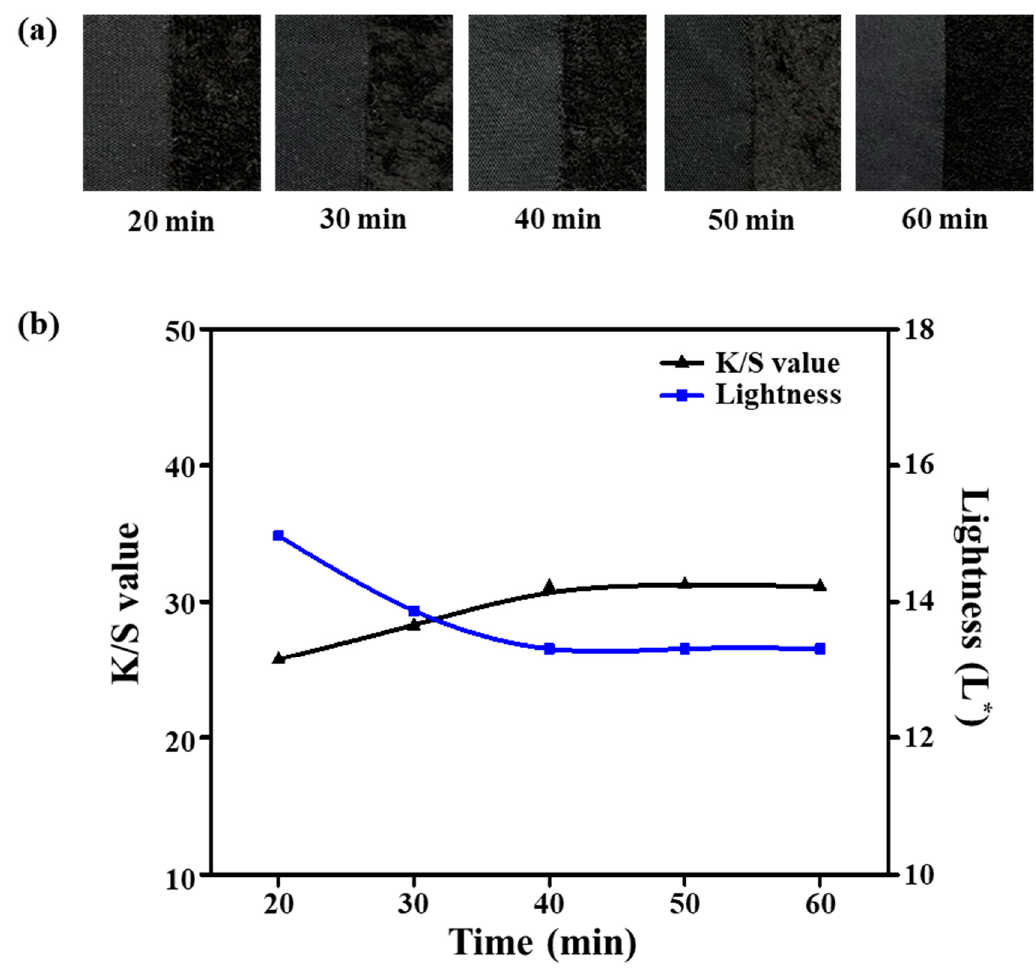
Figure 5. ( a ) Dyed samples. ( b ) K / S and lightness (L*) values according to dyeing time (20–60 min).